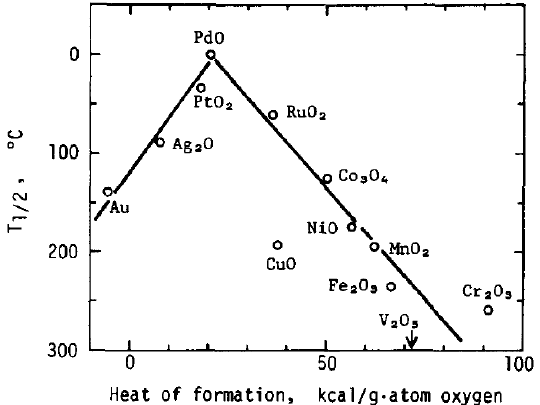
Figure 6. Dependence of catalytic hydrogen combustion (CHC) activities of metal oxides on their heat of formation (reproduced from [156] with permission from Elsevier).